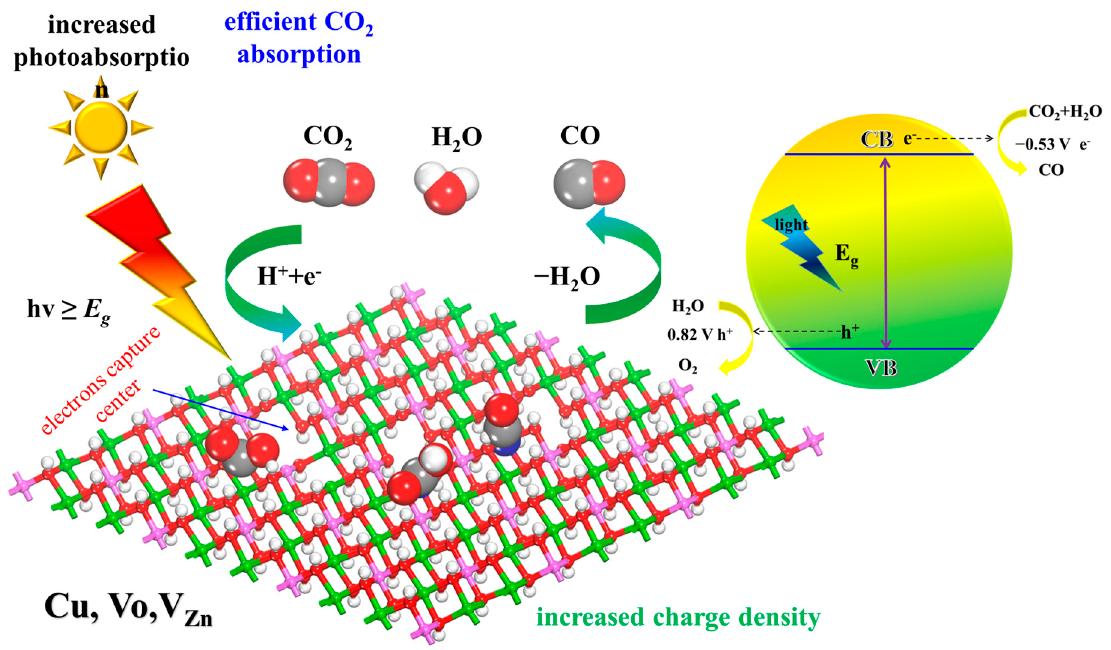
Figure 10. Illustration of the photocatalytic reduction mechanism of CO 2 . Atomic labels Al, Zn, Cu, C, O, and H are pink, green, blue, gray, red, and white, respectively.